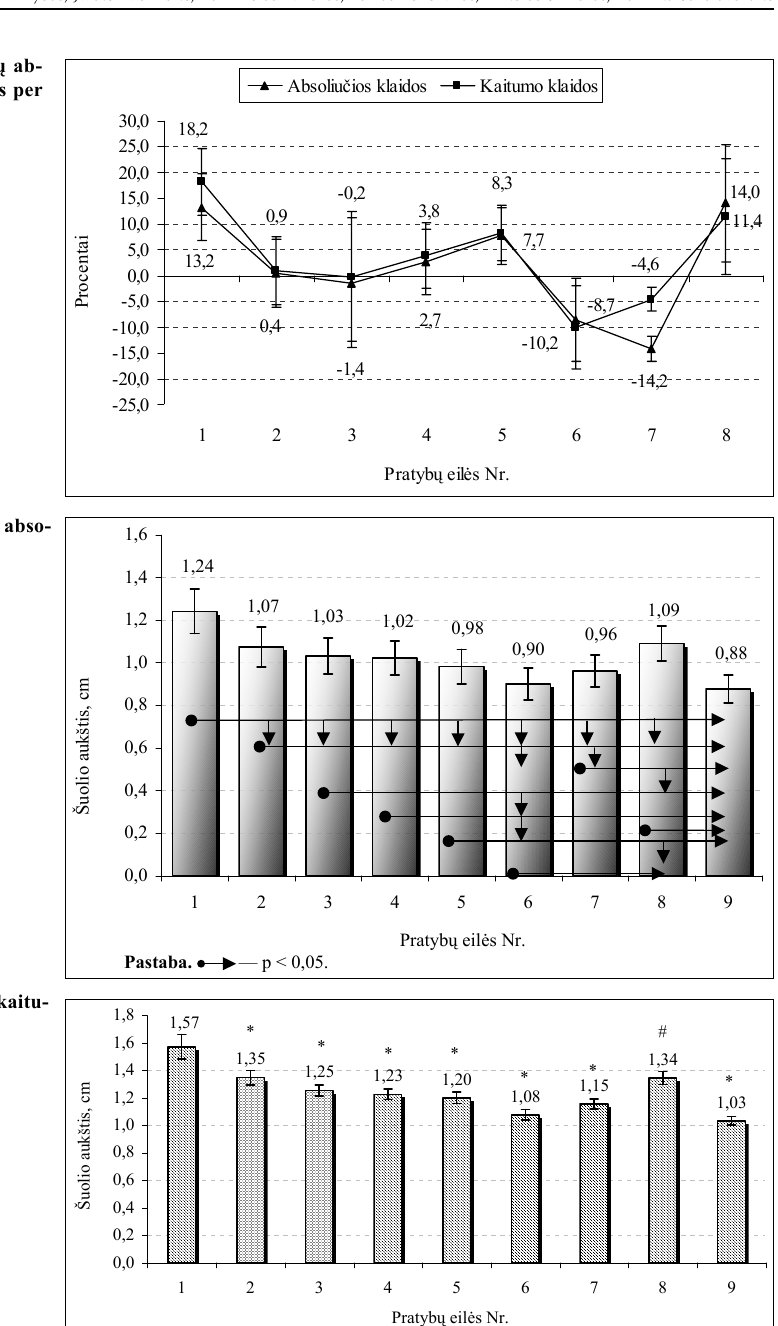
(42,3 ± 10,3%) klaidos labiausiai sumaž ė jo po pirm ų 10 šuoli ų (p < 0,05). Pirmose pratybose tiriamieji antrus 10 šuoli ų (1,0 ± 0,1 cm) jau atliko tiksliau nei pirmus 10 (2,0 ± 0,3 cm) (p < 0,05). Kaitumo klaidos pirmose pratybose taip pat labiausiai sumaž ė jo po pirm ų 10 šuoli ų (nuo 2,5 ± 0,2 iki 1,1 ± 0,1 cm; p < 0,05). Visose kitose pratybose statistiškai patikimo skirtumo tarp šuoli ų serij ų rodikli ų neaptikta (p > 0,05) (7 pav.). Atlikt ų pratyb ų skai č iaus ir šuoli ų serij ų absoliu č i ų klaid ų ryšys buvo statistiškai reikš-